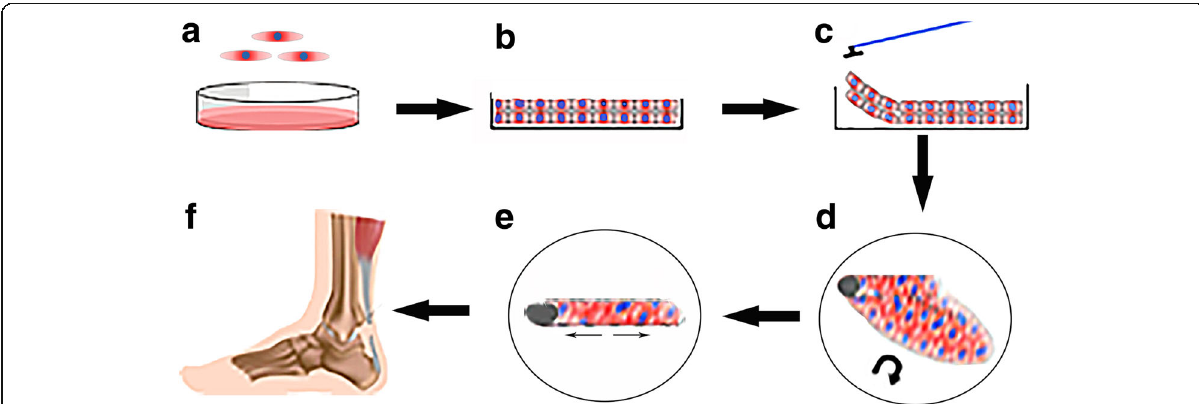
Fig. 3 Cartoon of the procedure to form tendon-like cell sheet. a MSCs are plated in cell culture dish; b Cell monolayers are formed; c and d The monolayer is scraped out from dish surface and rolled up into a cell sheet; e and f The three-dimensional cell sheet is cultivated under static tension and let to mature prior transplantation in